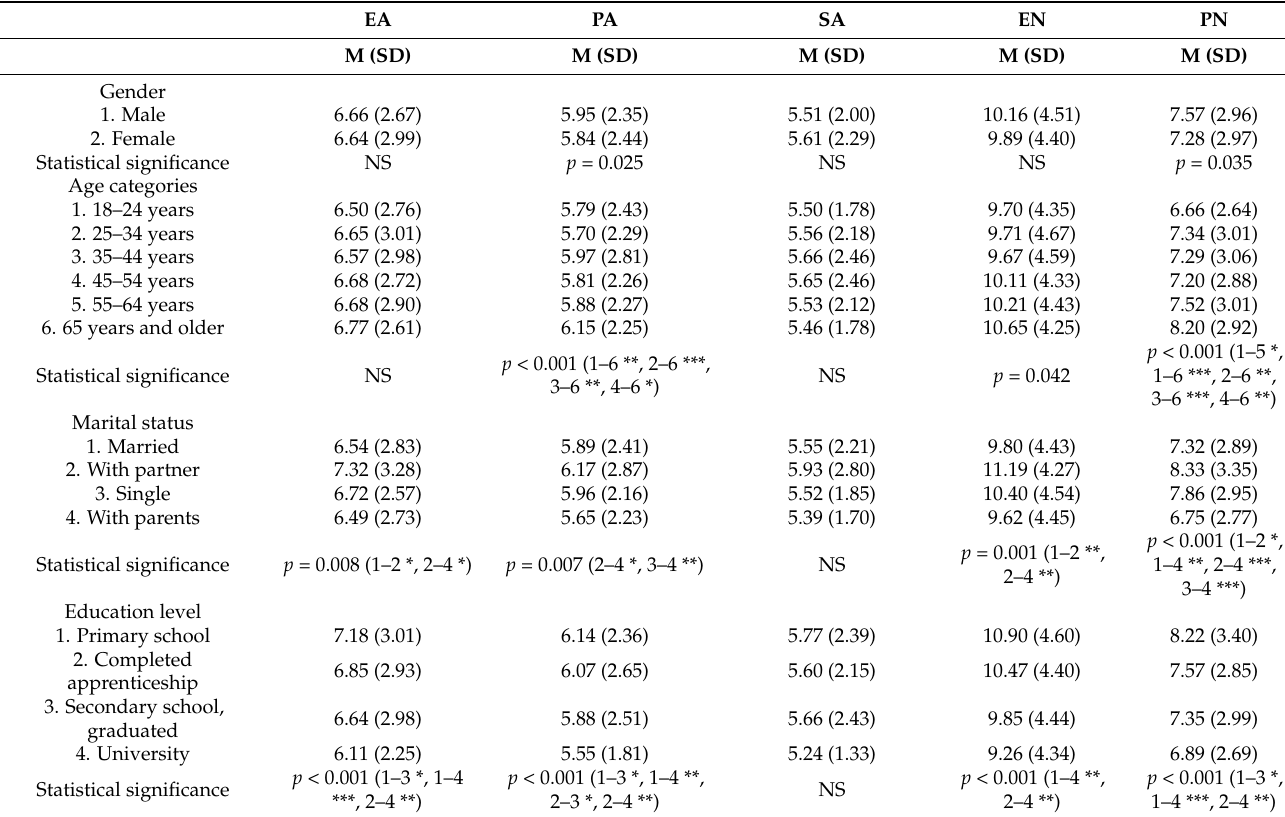
Table 6 shows the characteristics of the data set and the results of a nonparametric comparison of the summary score of the CTQ subscales (Mann–Whitney U test and Kruskal– Wallis test). The p -value corresponds to a comparison of all groups, while the relationships in parentheses are the result of multiple group comparisons. Table 6. Descriptive characteristics of the data set and nonparametric comparison of the summary scores in individual CTQ subscales in different population